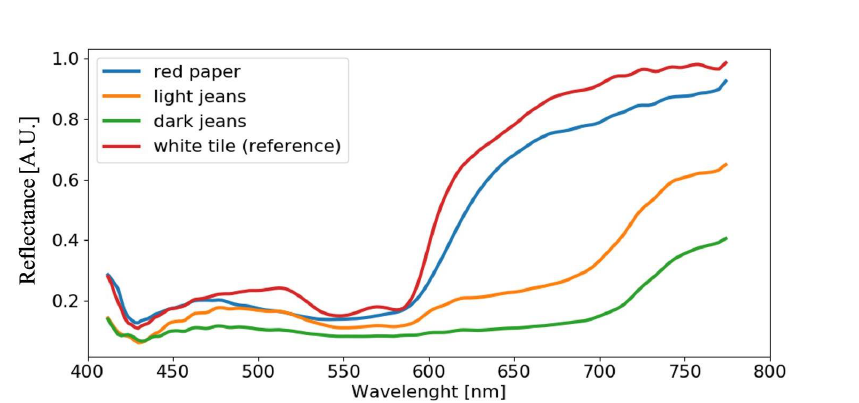
Figure 9. Reflectance spectra comparison on diverse substrates acquired at t = 0.5 h.